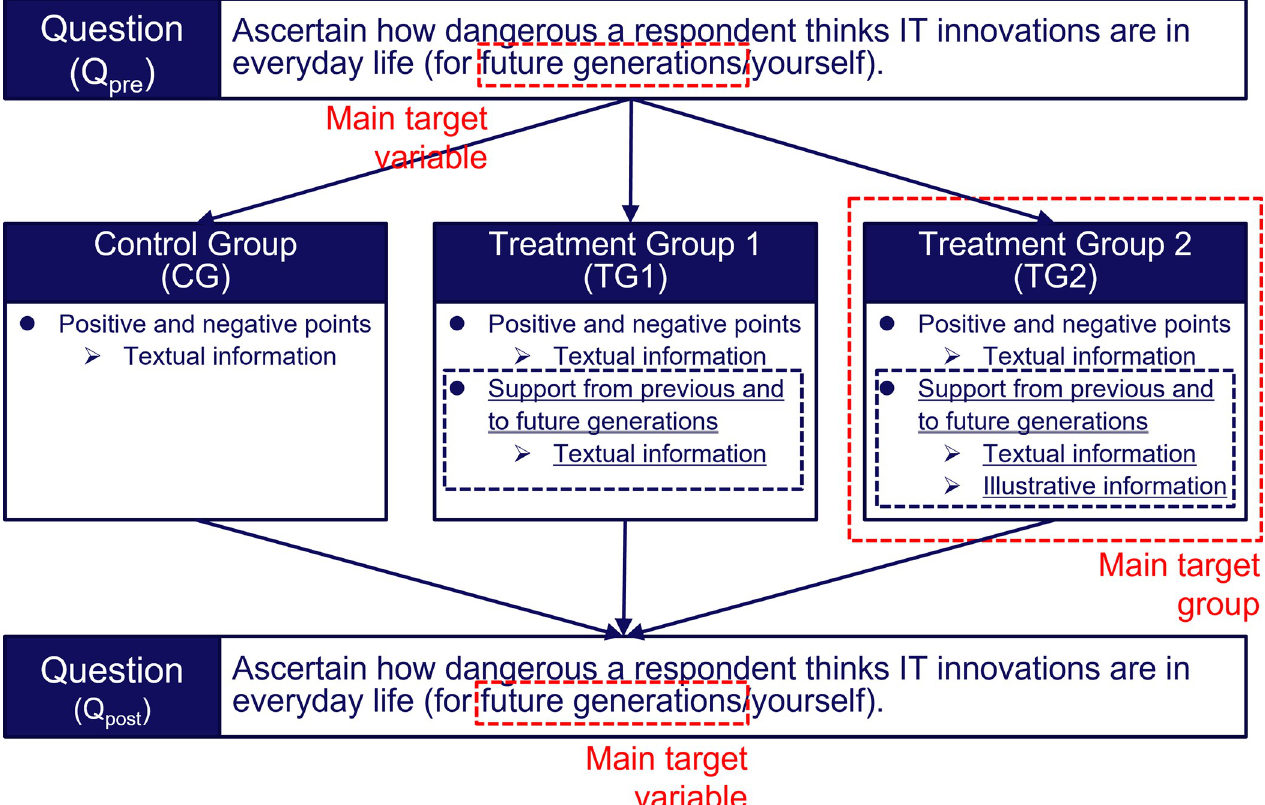
Fig 2. Flowchart of the experimental procedures. Black dashed lines indicate interventions. Red dashed lines indicate the main target of the interventions. This flowchart is a modified version of the experimental procedures in our previous study [36].